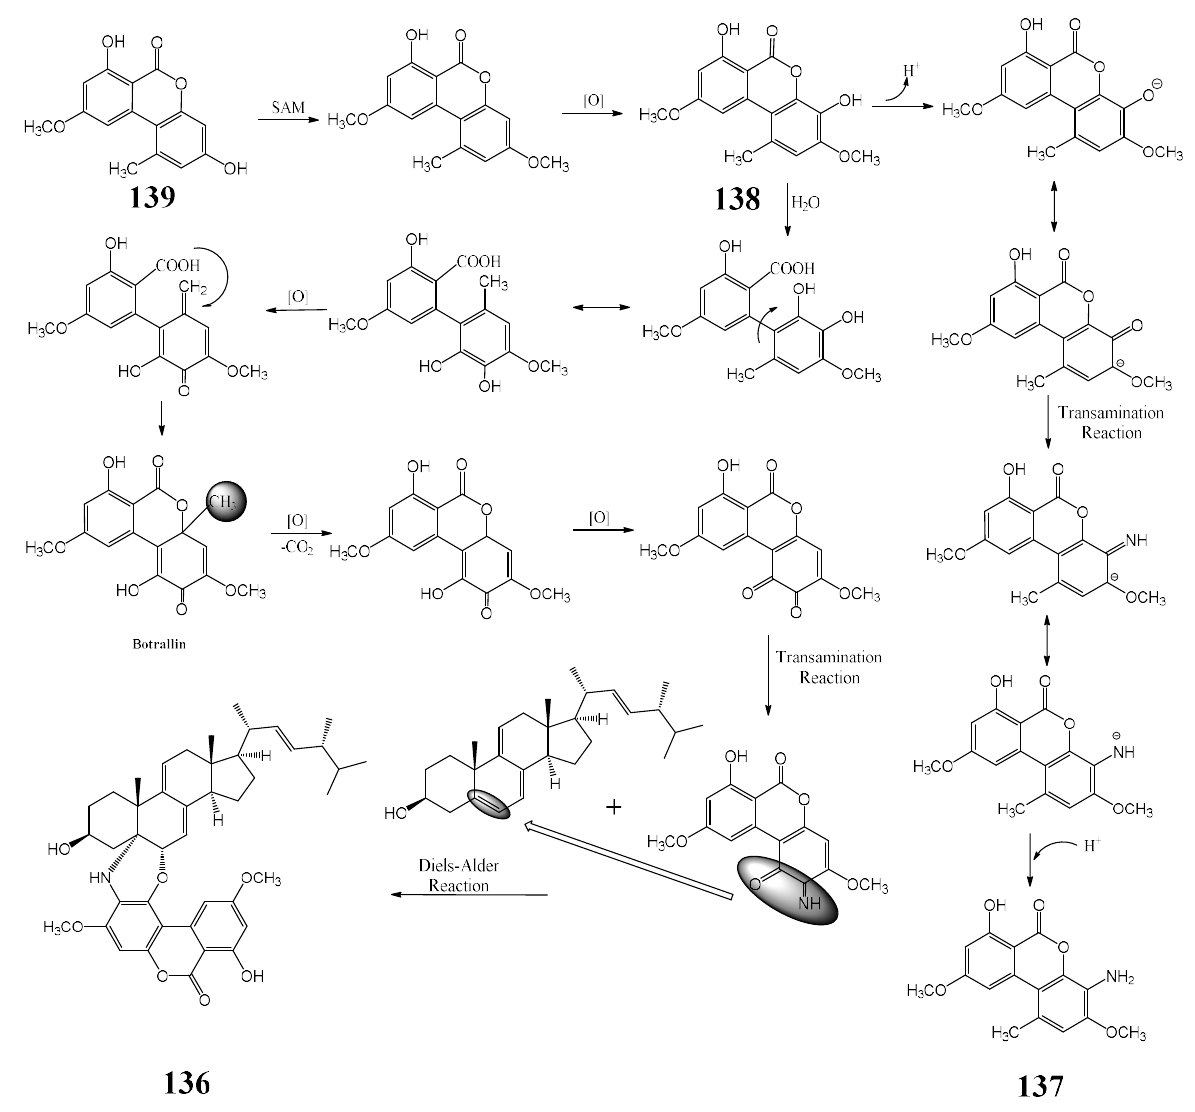
Figure 4. Plausible biogenetic correlation of pestauvicomorpholine A and three alternariol ana- logues